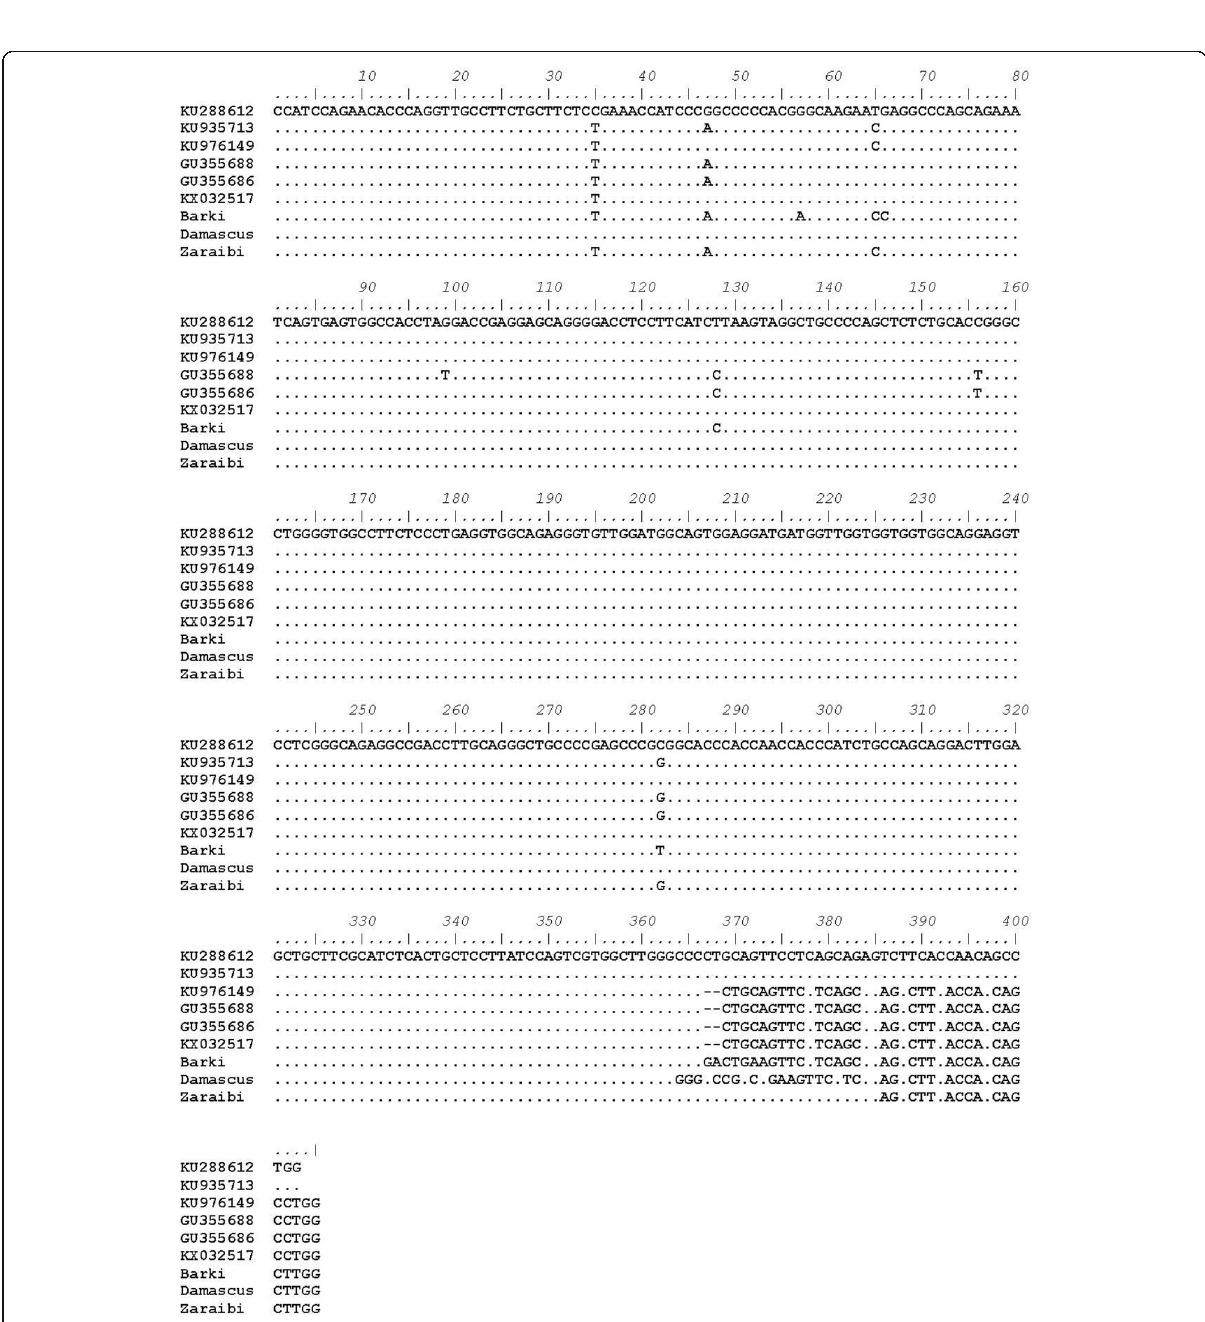
Fig. 3 Sequencing alignment for GH6 gene of three Egyptian goat breeds (Barki, Damascus, and Zaraibi) in comparison with Genbank entries to describing different new detected